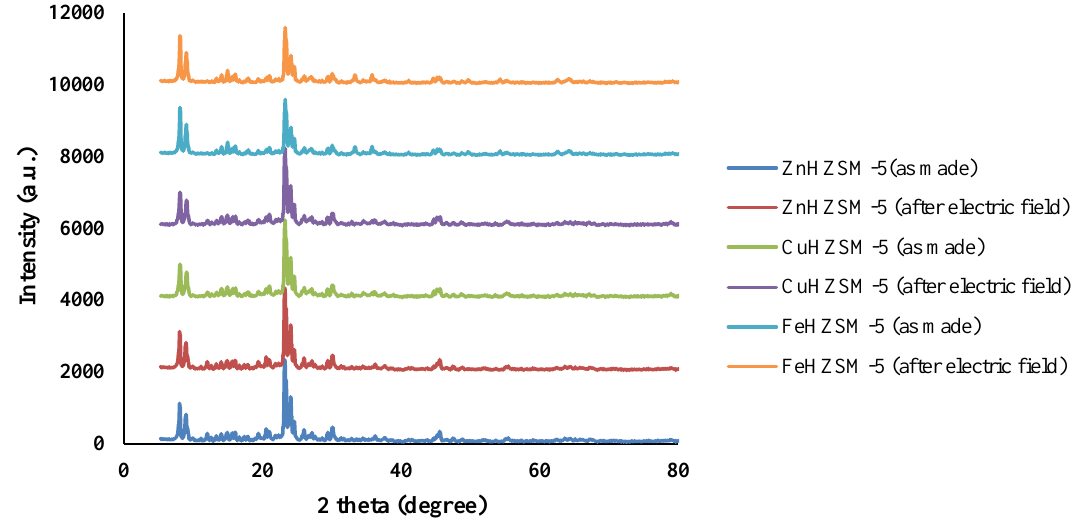
Figure 1. XRD patterns for NaZSM-5, HZSM-5, 4 wt. %. FeHZSM-5, 4 wt. %. CuHZSM-5 and 4 wt. %. ZnHZSM-5 catalysts in conventional reaction and reaction in the electric field.